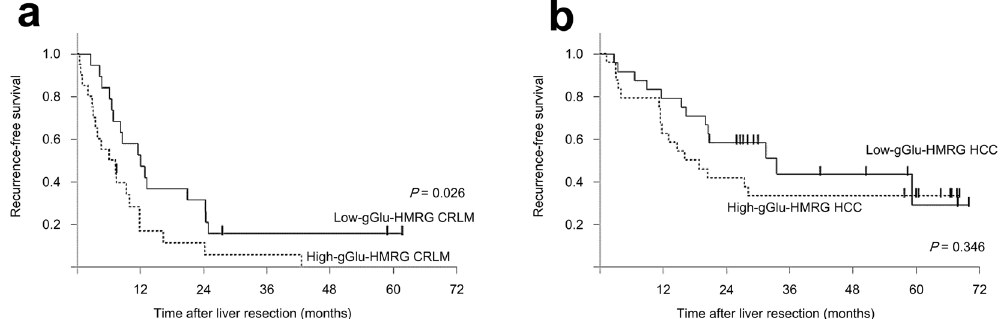
Figure 6. Postoperative recurrence-free survival of CRLM and HCC patients stratified by tumor fluorescence intensity after gGlu-HMRG application. ( a ) Kaplan–Meier curves of recurrence-free survival of patients with tumors classified as Low-gGlu-HMRG CRLMs ( n = 19, solid line) or High-gGlu-HMRG CRLMs ( n = 20, dotted line). Two-year recurrence-free survival rates were 32% and 11%, respectively ( P = 0.026, log-rank test). ( b ) Kaplan–Meier curves of recurrence-free survival of patients with tumors classified as Low-gGlu-HMRG HCCs ( n = 24, solid line) or High-gGlu-HMRG HCCs ( n = 24, dotted line). Two-year recurrence-free survival rates were 58% and 42%, respectively ( P = 0.346, log-rank